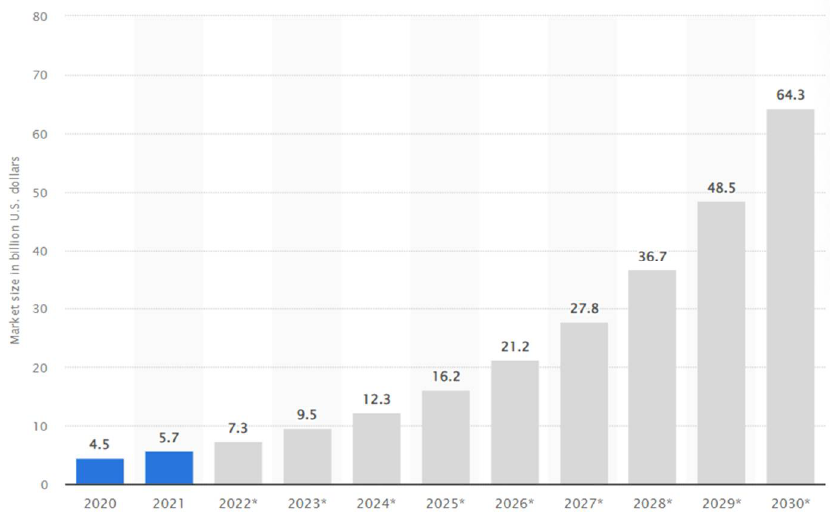
Figure 1. Size of Maintenance 4.0 market worldwide in 2020 and 2021 with forecast for future years indexed by * (from 2022 to 2030) [6,7] .